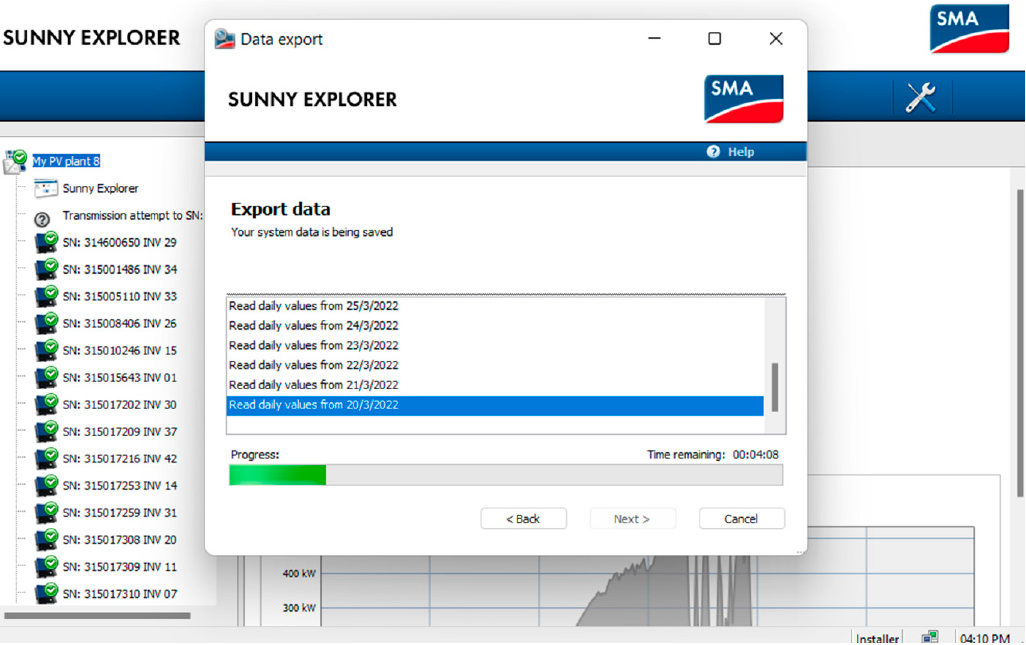
Figure 7. Data logging platform using Sunny Explorer for electrical output.